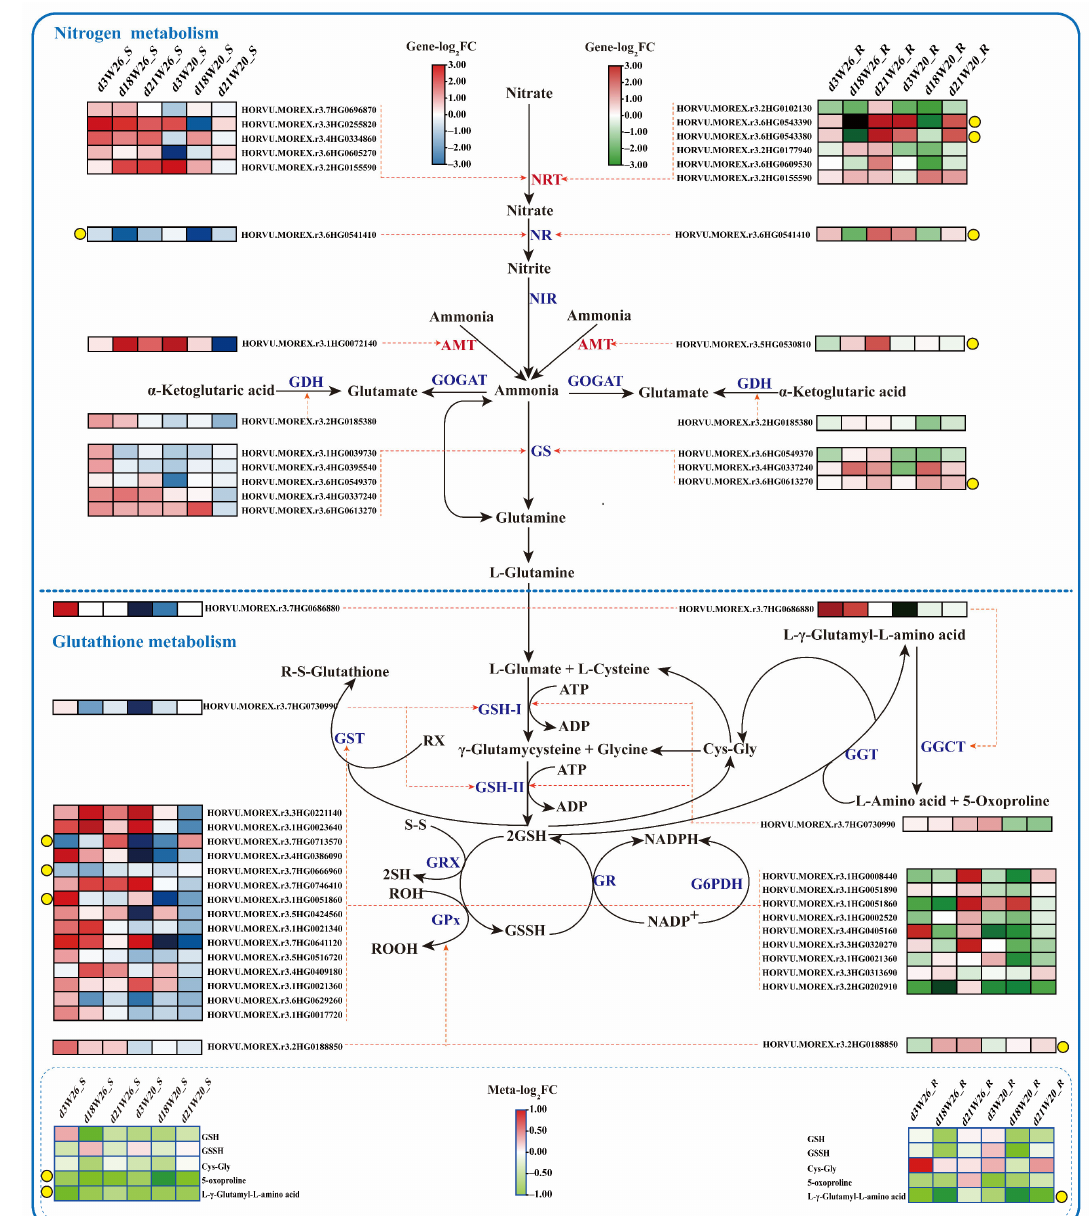
Figure 9. Nitrogen metabolism and GSH metabolism pathways. NR, nitrate reductase; NIR, nitrite reductase; GOGAT, glutamate synthetase; GDH, glutamate dehydrogenase; GS, glutamine synthetase; NRT, nitrate transporter; AMT, ammonium transporter; GSH ‐ 1, γ‐ Glutamyl cysteine synthetase; GSHII, glutathione synthetase; ATP, adenosine triphosphate; S ‐ S, disulfide bond; SH, sulfhy ‐ dryl; ADP, adenosine diphosphate; RX, organic halide; GST, glutathione S ‐ transferase; GRX, glu ‐ taredoxin; GPx, glutathione peroxidase; ROOH, hydroperoxide; ROH, hydroxide; G6PDH, 6 ‐ phos ‐ phate glucose dehydrogenase; GR, glutathione reductase; GSH, glutathione (reduced glutathione); GSSH, oxidized glutathione; Cys ‐ Gly, cysteine glycine; GGT, glutamyltransferase; R ‐ S ‐ glutathione, glutathione thioate; GGCT, γ‐ Glutamic acyltransferase. FC (FoldChange) is the multiple of relative expression. “Meta” stands for metabolite. The small square in the figure represents the relative ex ‐ pression of genes or metabolites in W26 and W20. The red word represents the transporter. The yellow dot in the figure represents that the relative expression trend of the gene or metabolite at the corresponding sampling time in the two genotypes is similar. “d3W26_S” represents the leaves sam ‐ pled by W26 on the 3rd day. “d18W26_S” represents the leaves sampled by W26 on the 18th day.